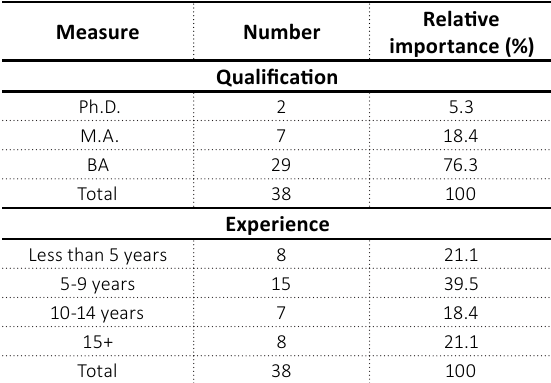
Table 3. Relative importance of scientific